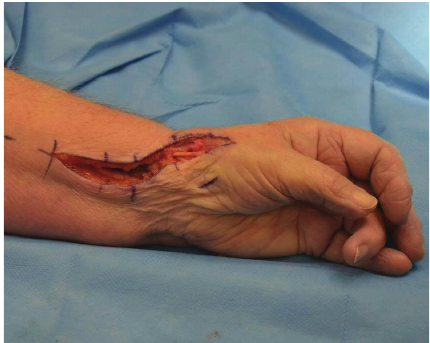
Figure 2: Surgical incision for CMC joint arthroplasty of left thumb.